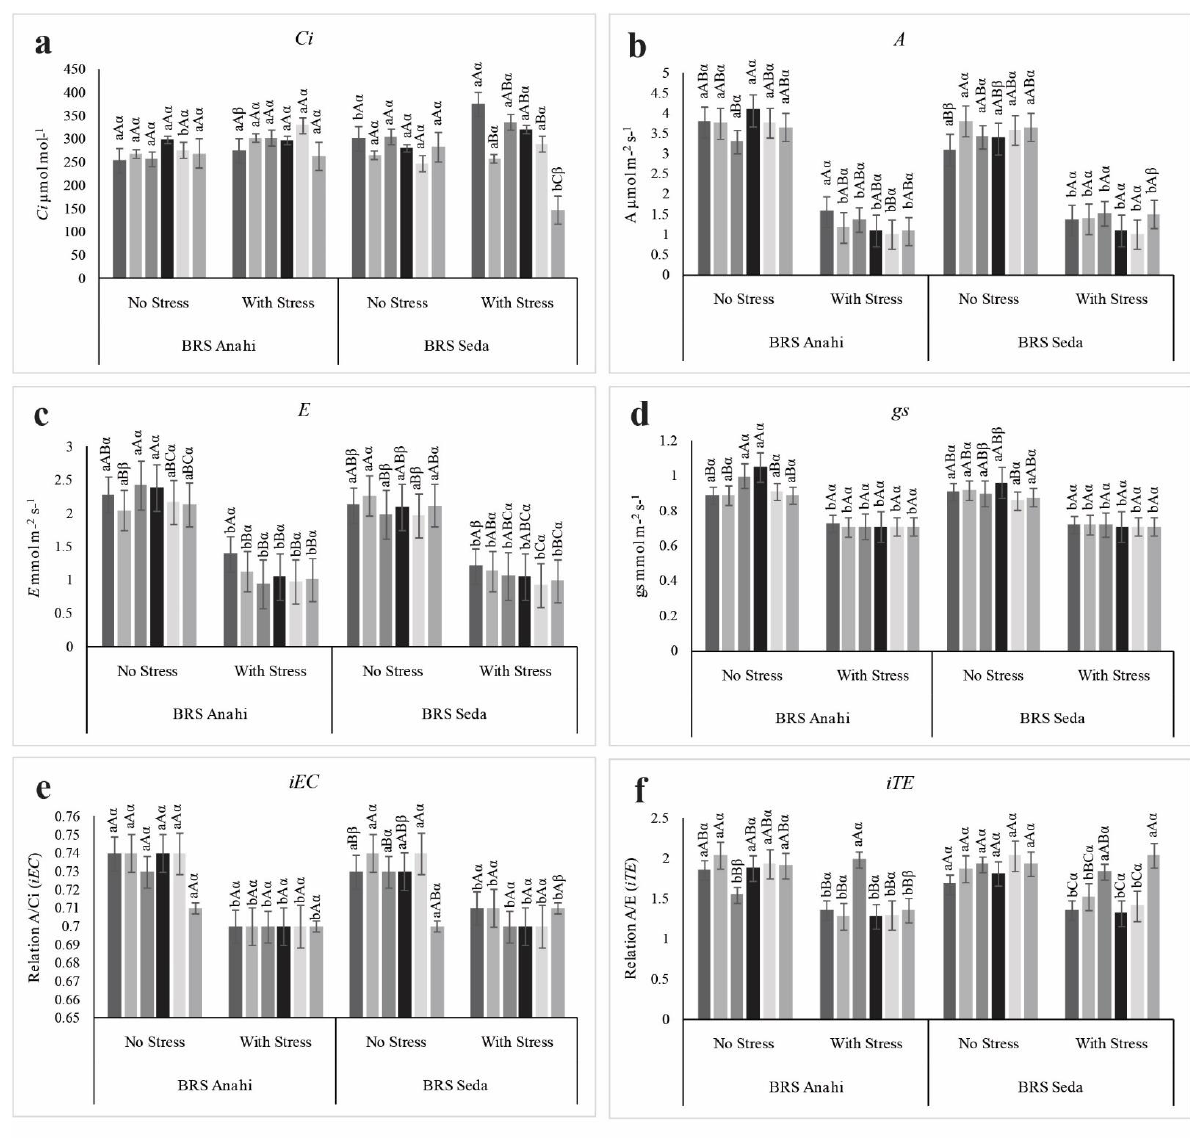
Figure 1. ( a ) Internal CO 2 concentration (Ci), ( b ) photosynthesis (A), ( c ) transpiration (E); ( d ) stomatic conductance (gs), ( e ) instantaneous efficiency of carboxylation (iEC), ( f ) instantaneous